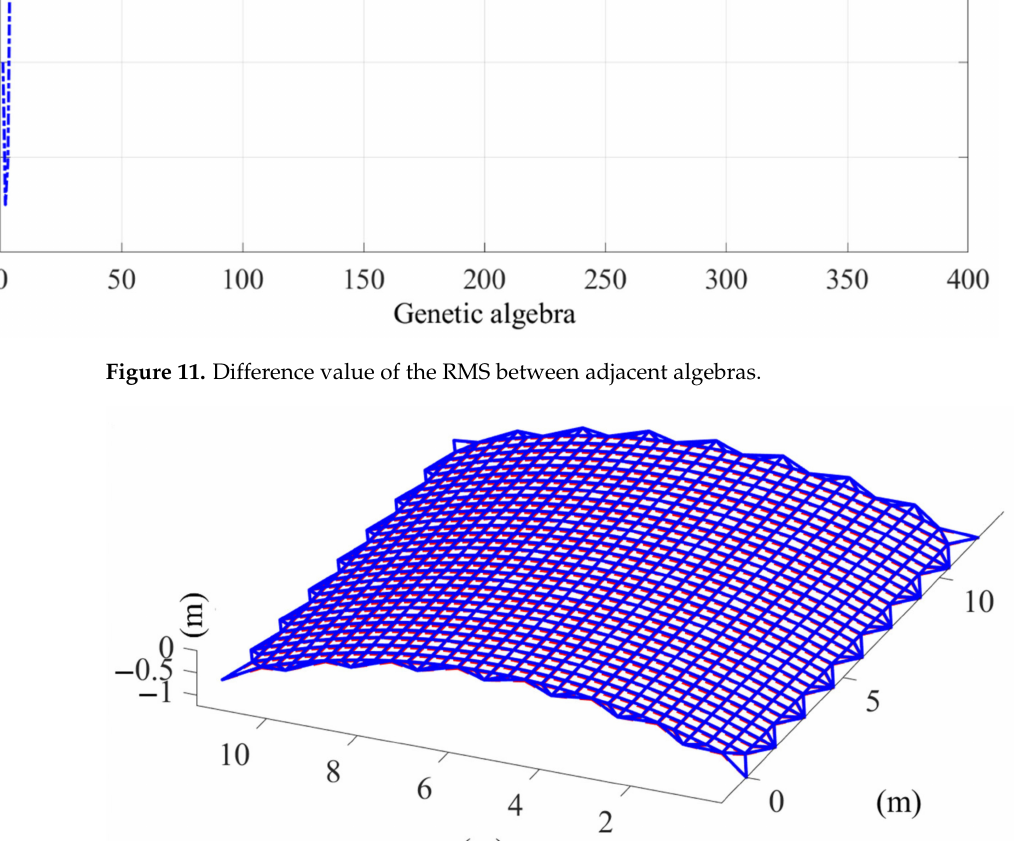
Figure 12. The optimized form-finding configuration of the mesh